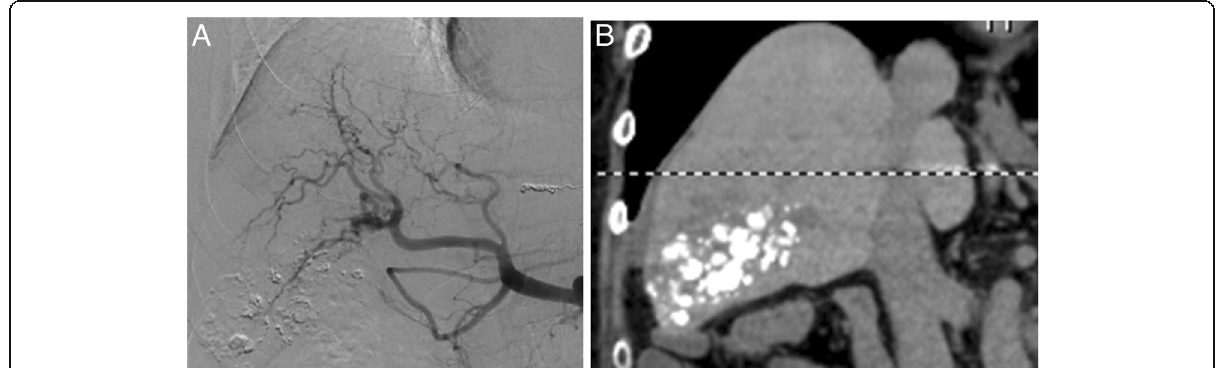
Fig. 2 Diagnostic images at the fourth chemoembolization procedure. a Digital subtraction angiography. b Plain CT after chemoembolization. The main tumor is markedly diminished with no enhancement, and lipiodol showed spotty but strong accumulation